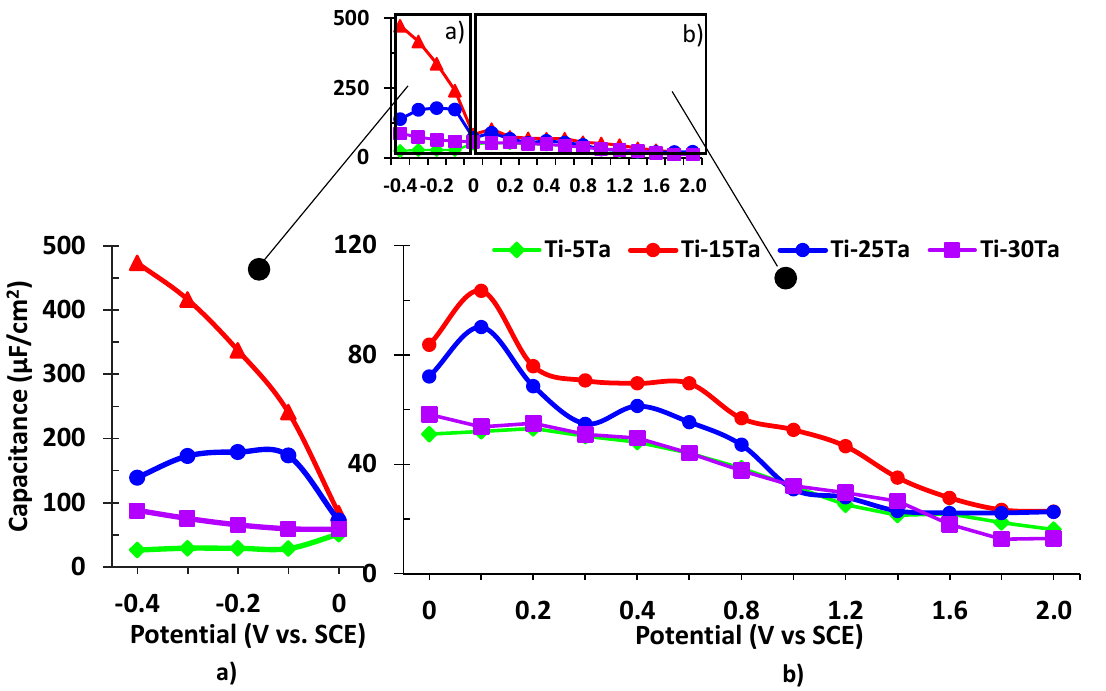
Figure 11. Capacitance of the passive films for Ti–Ta alloys in simulated body fluid: ( a ) at negative potentials; ( b ) at positive potentials.